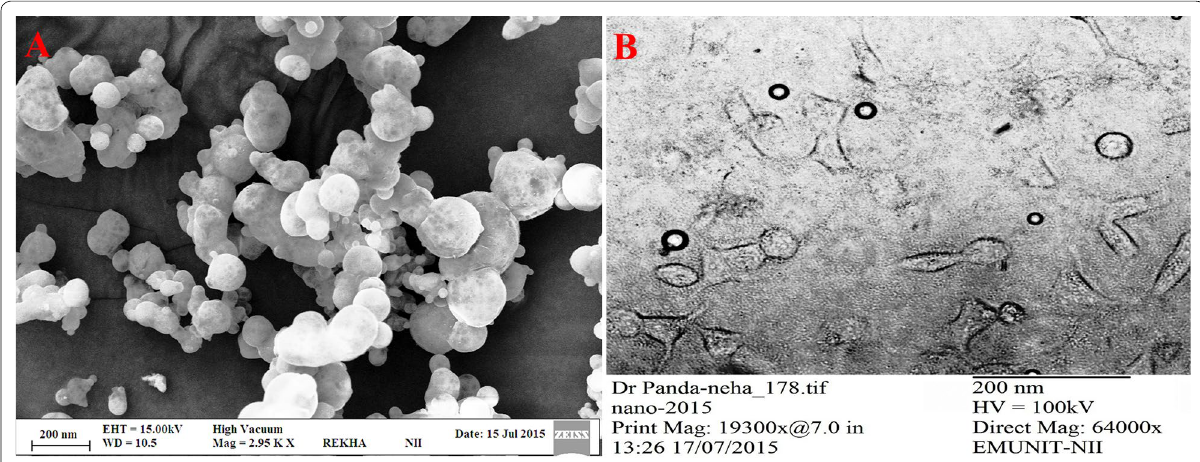
Fig. 2 Scanning electron microscopy (SEM) ( A ) and Transmission electron microscopy (TEM) ( B ) images of DOX-loaded-PEG-PLGA-NPs